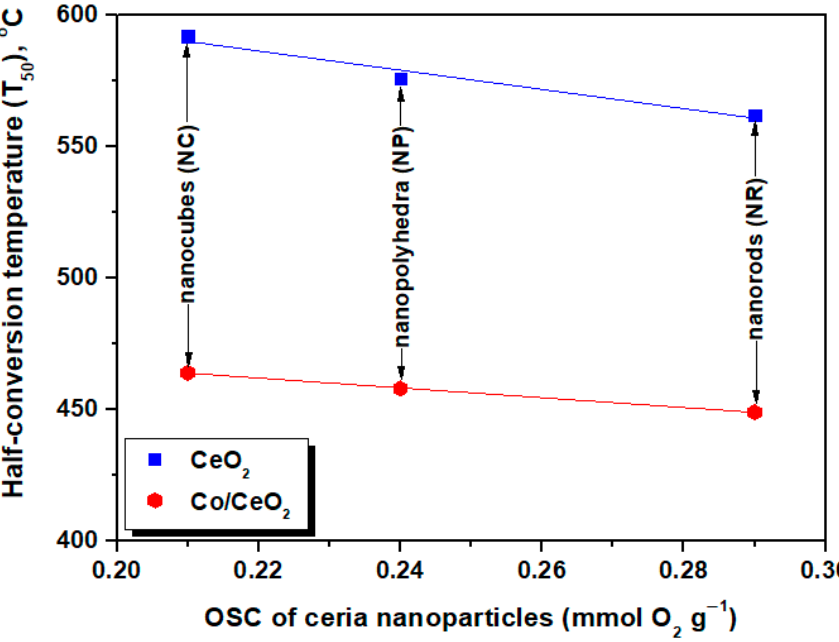
Figure 11. Relationship between the deN 2 O performance and the OSC (mmol O 2 g − 1 ) of bare CeO 2